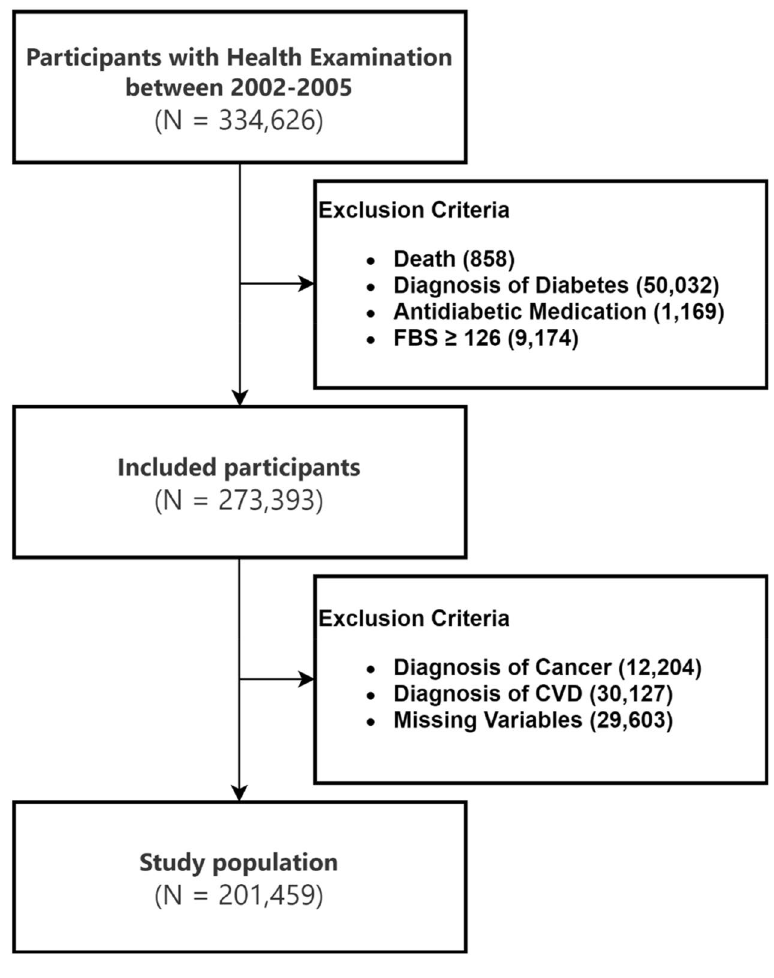
Figure 1. Study sample